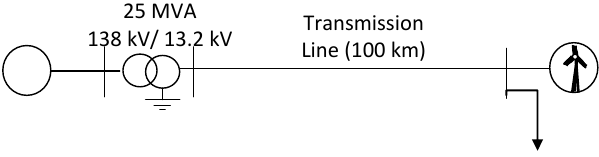
Figure 7. Simple test system to validate the average model.